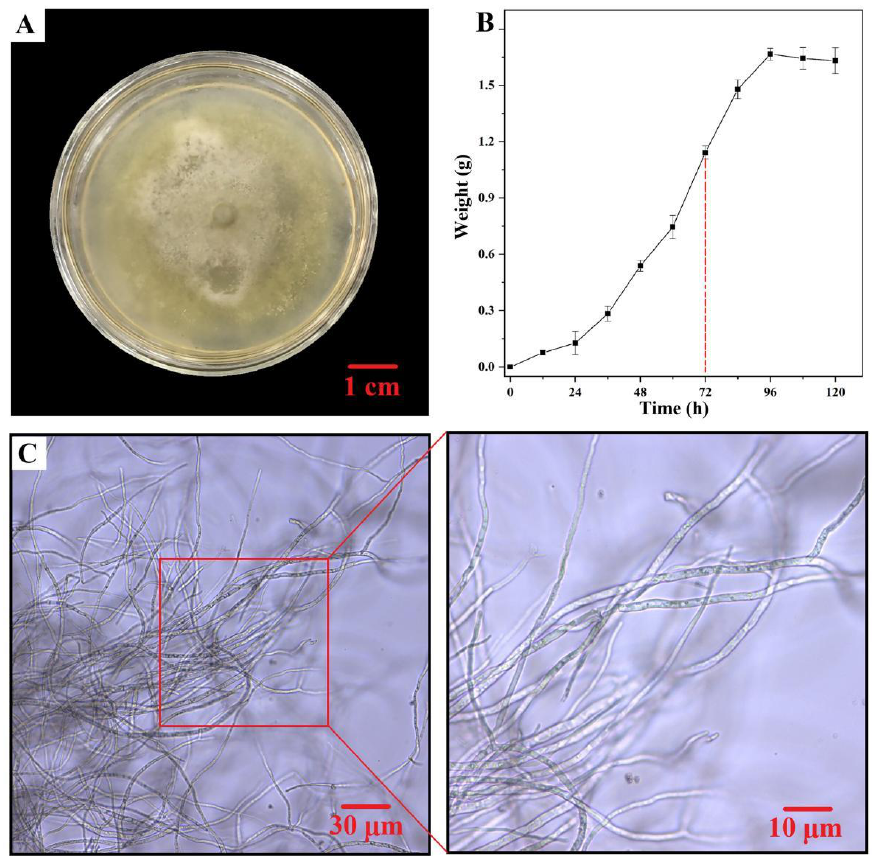
Figure 1. Biological morphology ( A ), growth curve test ( B ), and optical microscope structure obser- vation results ( C ) of T. reesei .